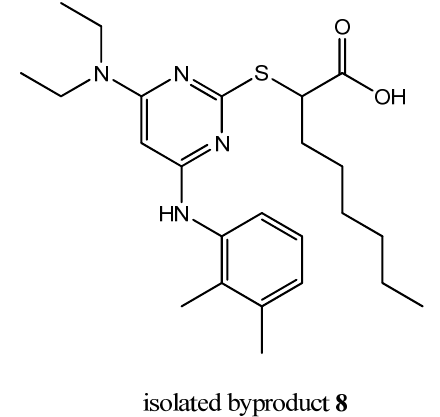
Figure 3. Chemical structure of the isolated byproduct 8